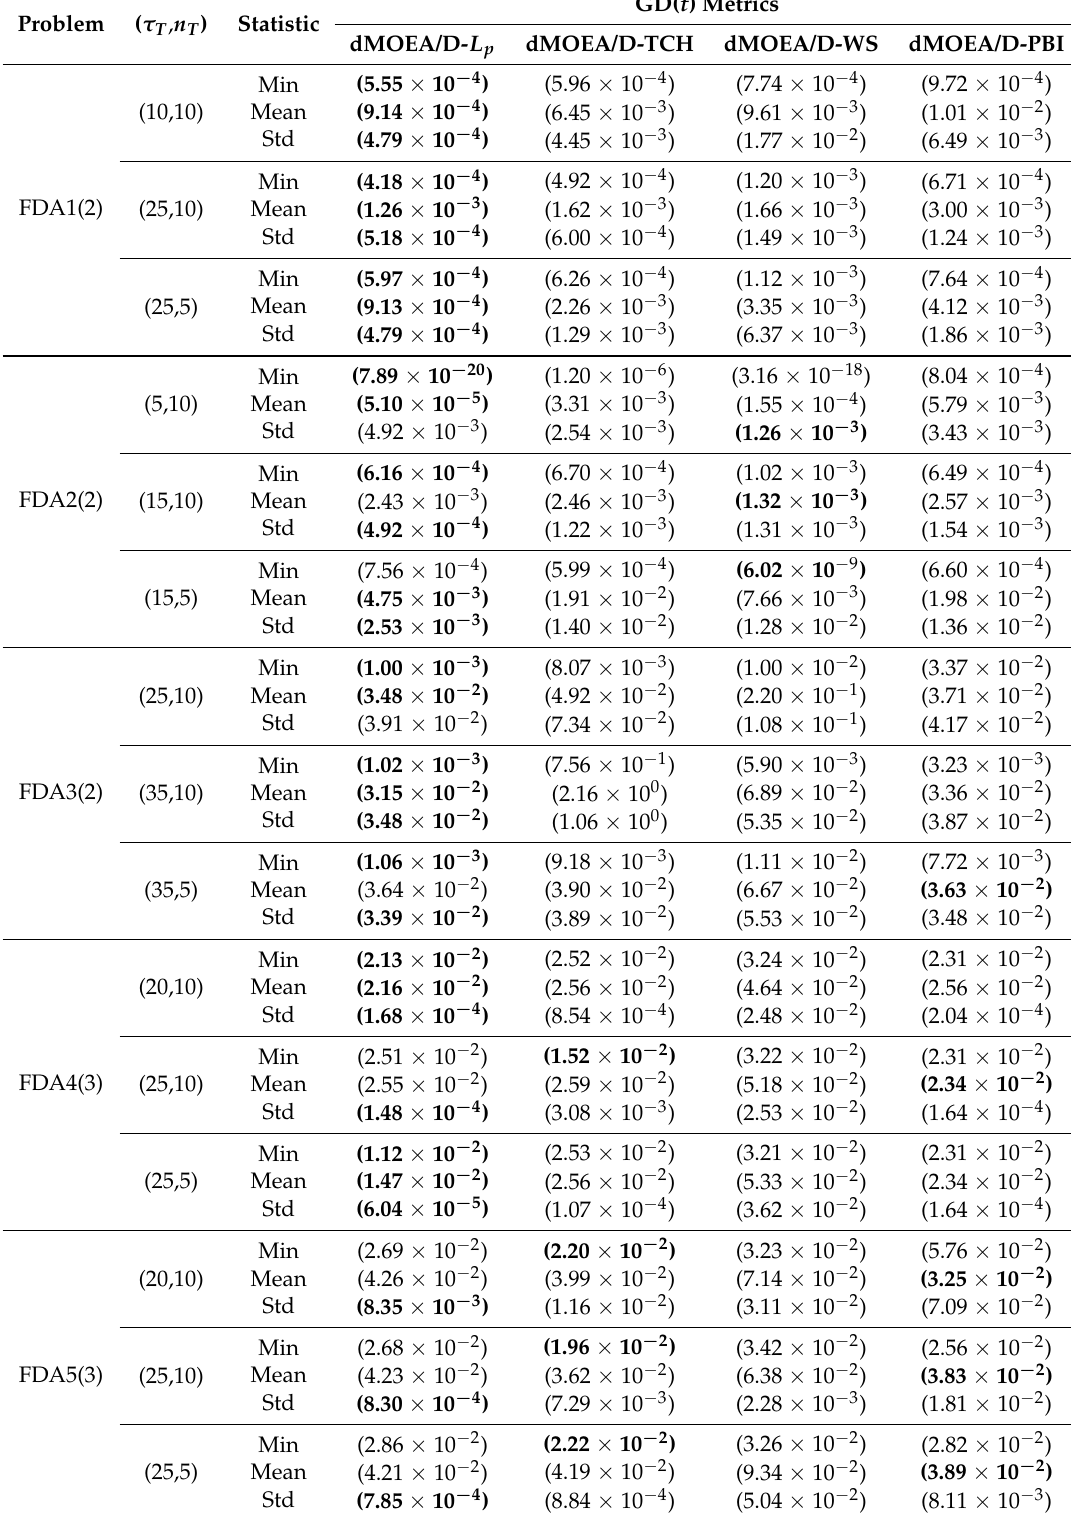
Table 5. The best, mean, and standard deviation of GD( t ) metric values obtained by dMOEA/D- L p and the other versions of dMOEA/D on test problems based on 30 independent runs. The best performance of each metric value is marked in